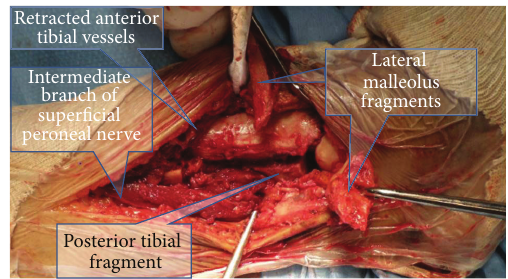
Figure 3: Transfibular approach to the lateral distal tibia. Note the intermediate branch of the superficial peroneal nerve as well as the anterior tibial vessels. The flipped-over lateral malleolus still retains the posterior (peroneal artery derived) blood supply.